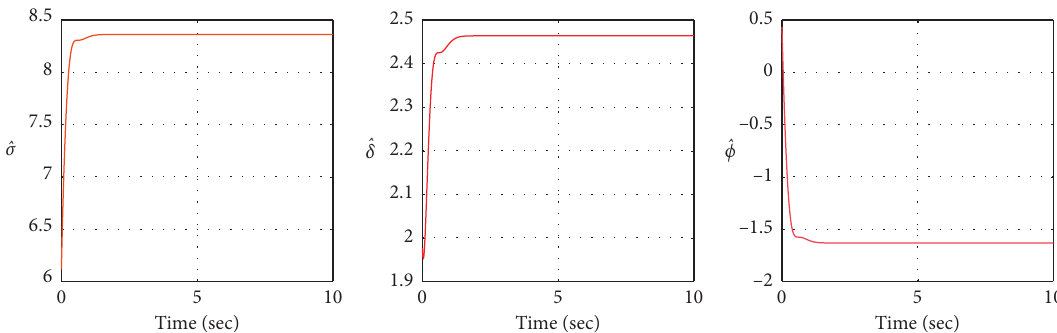
Figure 6: Changing of the tuned parameters ( 􏽥 σ , 􏽥 δ , and 􏽥 ∅ ) over time.